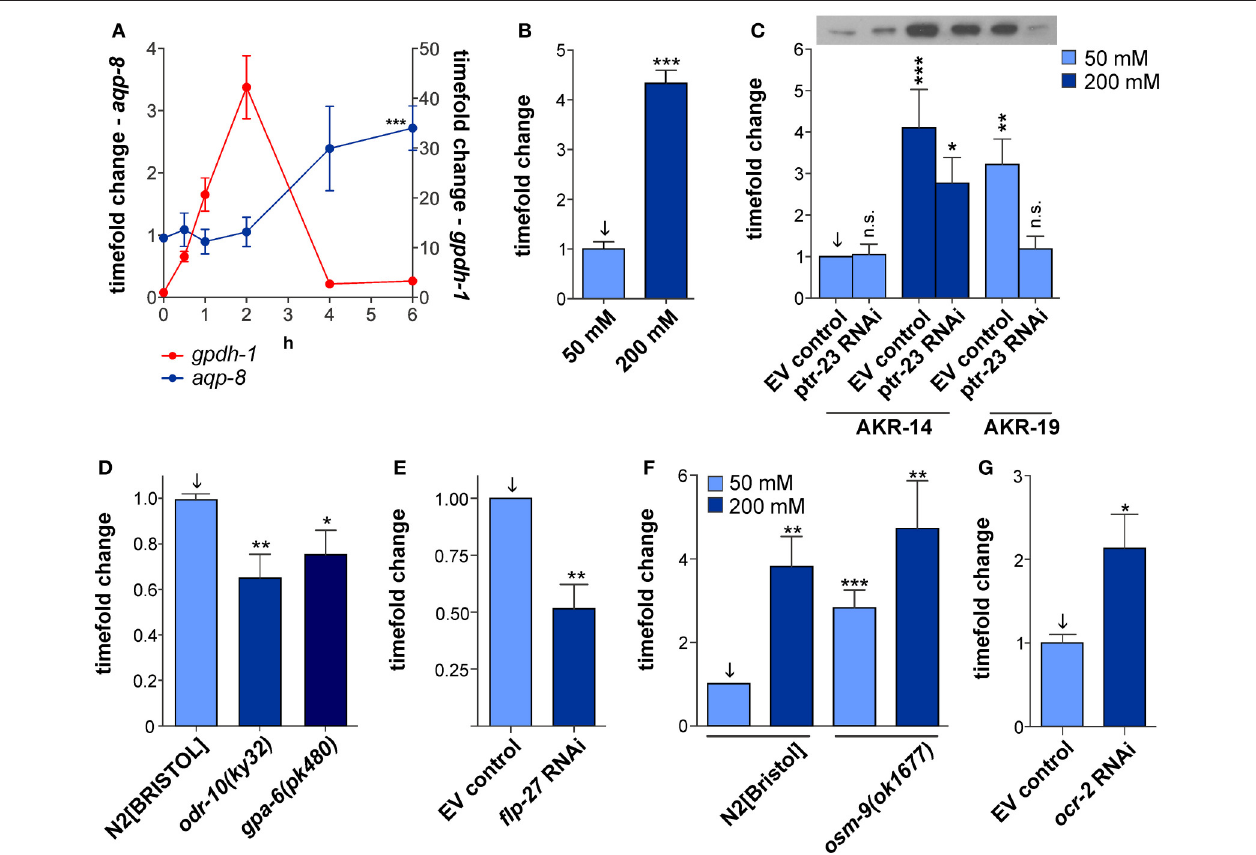
FIGURE 3 | Possible regulatory pathways of aqp-8 expression. (A) Comparison of aqp-8 and gpdh-1 mRNA expression pattern after acute osmotic stress onset in a N2[BRISTOL] background, gpdh-1 (red circle, right y-axis) and aqp-8 (blue circle, left y-axis). The 0h control was set to 1. A Student’s t -test for aqp-8 induction was performed between 6h 50mM (Supplementary Figure 4) and 6h 200mM stress conditions. N > 4 (B) qPCR analysis of the aqp-8 mRNA expression under chronic osmotic stress conditions in an gpdh-1(ok1558) mutant background. A Student’s t -test were performed between 50mM NaCl control condition (light blue) and chronic osmotic stress conditions (dark blue); N = 6. (C) Western blot analysis of the ptr-23 RNAi effect on AQP-8 protein concentrations in ARK-14; + / + ; aqp-8 ::GFP and AKR-19 ;osm-8(n1518);aqp-8 ::GFP background. A sample western blot is shown above the graph, loaded in the same order as the subjacent graph. Student’s t -tests were performed compared to AKR-14 EV control conditions (set to 1); N > 4 (D) qPCR analysis of the of aqp-8 mRNA expression levels in osr-10(ky32) and gpa-6(ok480) strains on 50mM NaCl compared to wild type N2[BRISTOL]. Student’s t -tests were performed between N2[BRISTOL] (arrow) and the two strains. N > 6 (E) Western blot analysis of flp-27 RNAi impact on AQP-8::GFP expression. A Student’s t -test was performed against wild type control (arrow). N = 4 (F) qPCR analysis of the of aqp-8 mRNA expression levels in osm-9(ok1677) compared to wild type N2[BRISTOL] under control and osmotic stress conditions. Student’s t -tests were performed and results compared to wild type control (arrow). N > 6. (G) Western blot analysis of ocr-2 RNAi impact on AQP-8::GFP expression. A Student’s t -test was performed against wild type control (arrow). N = 7. All qPCR expression levels were normalized to act-2 (actin). Western blot results were normalized to whole protein. All values are indicated relative to control conditions (set to 1). * p < 0.05; ** p < 0.01; *** p < 0.001; n.s., not